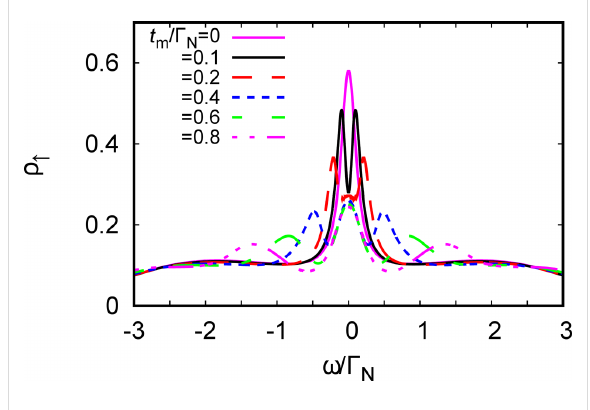
Figure 9: The spectral function ρ ↑ ( ω ) of the half-filled quantum dot ( ε = − U /2) obtained at T = 0 for Γ S / Γ N = 2, U / Γ N = 4 and several values of t m (as